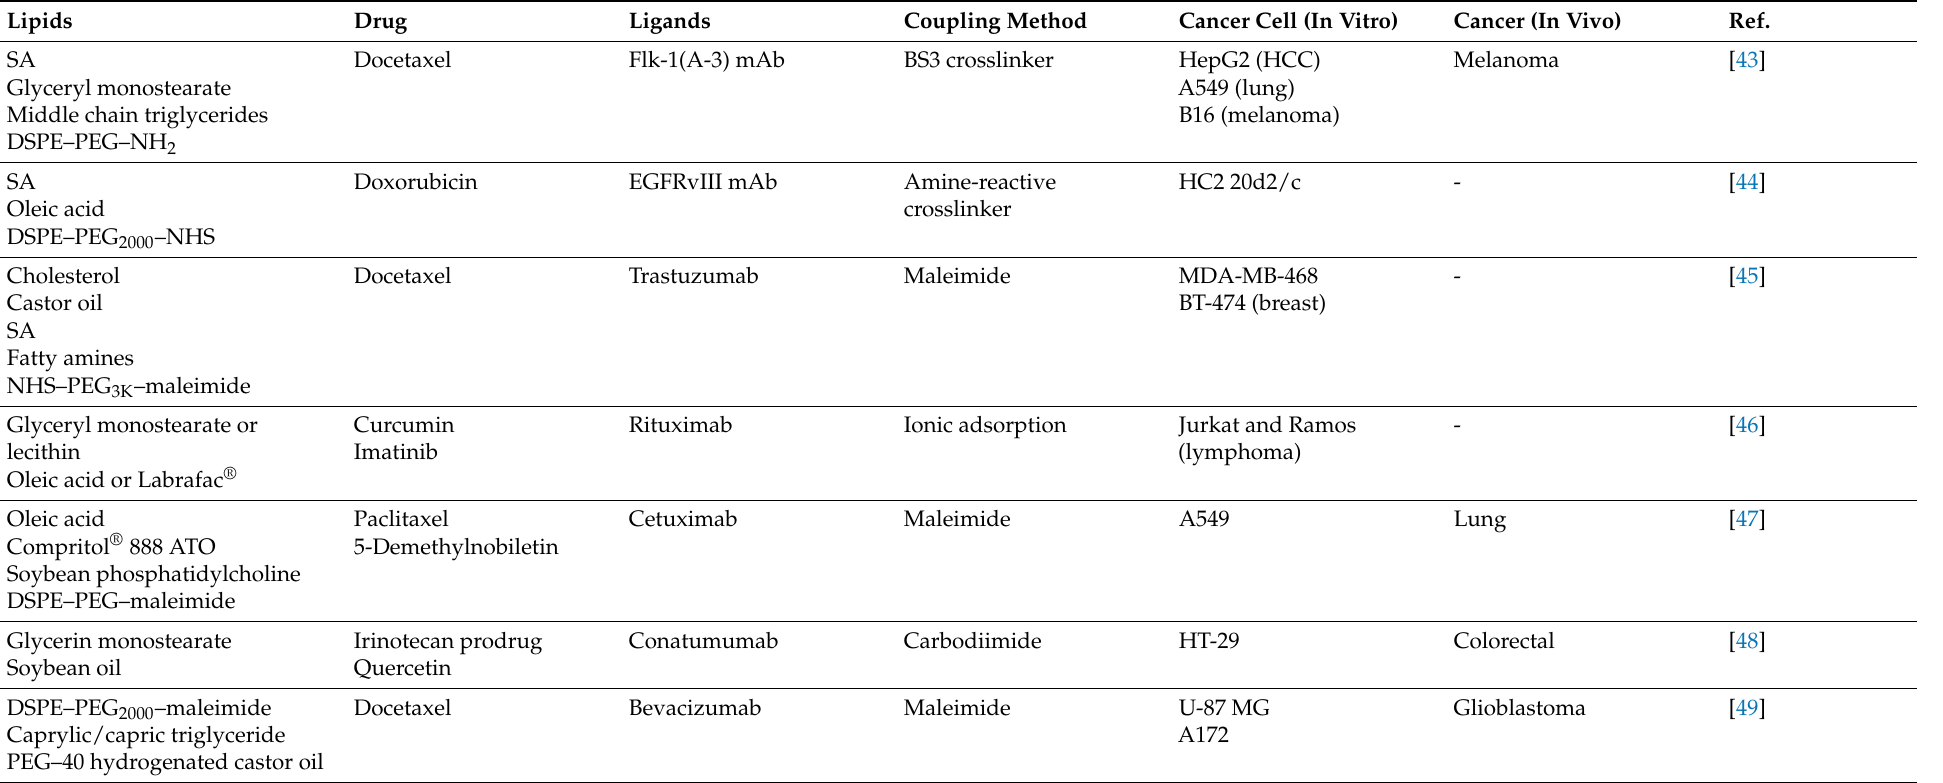
Table 2. Antibody-functionalized NLC for anticancer drug